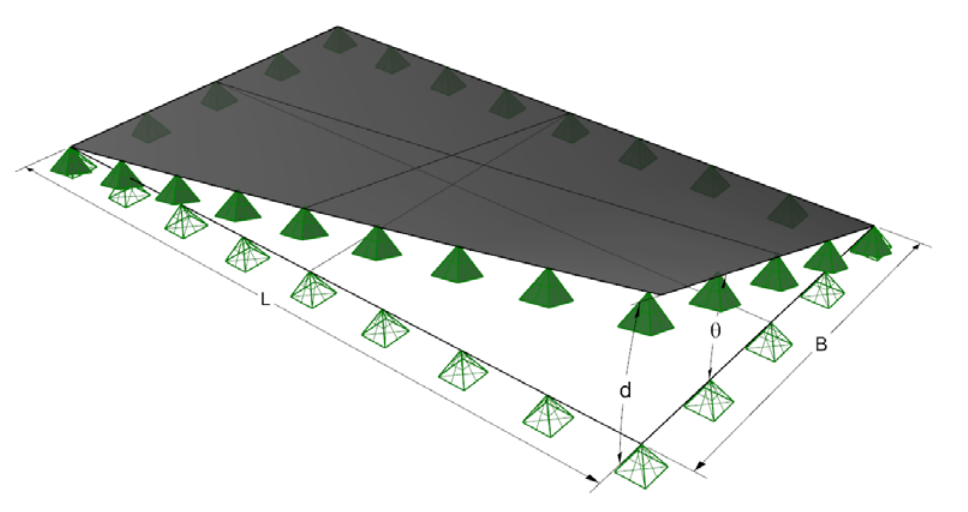
Fig. 3 Warping geometry nomenclature and support